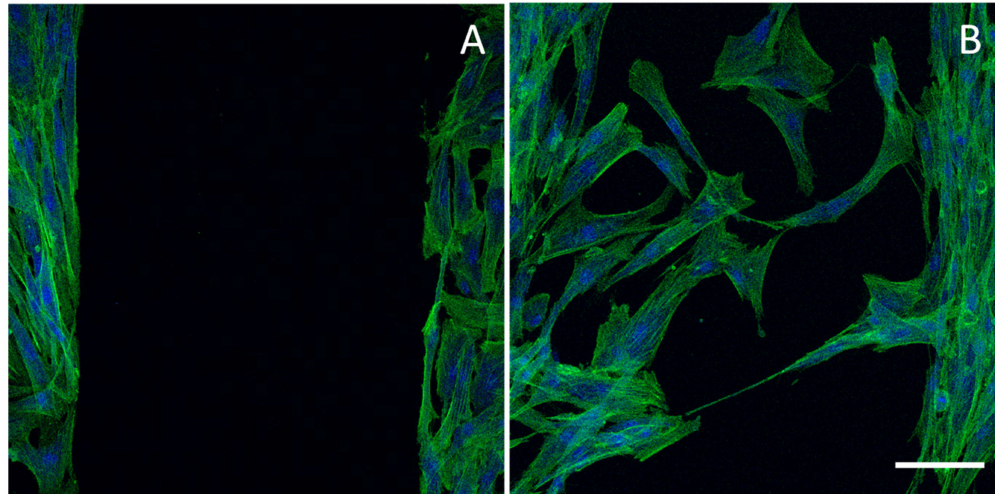
Figure 5. CLSM (confocal laser scanning microscope) images of a cell substrate (normal human dermal fibroblasts) with a free cell area (lesion) obtained using an insert (panel ( A )) and the same substrate 24 h after the insert removal characterized by cells migrated / proliferated in the free area (panel ( B )) (the cell substrate has been stained with phalloidin-FITC (green, F-actin filaments) and DAPI (blue, nucleus)). Scale bar 100 µ m. Modified from [135]. CC BY